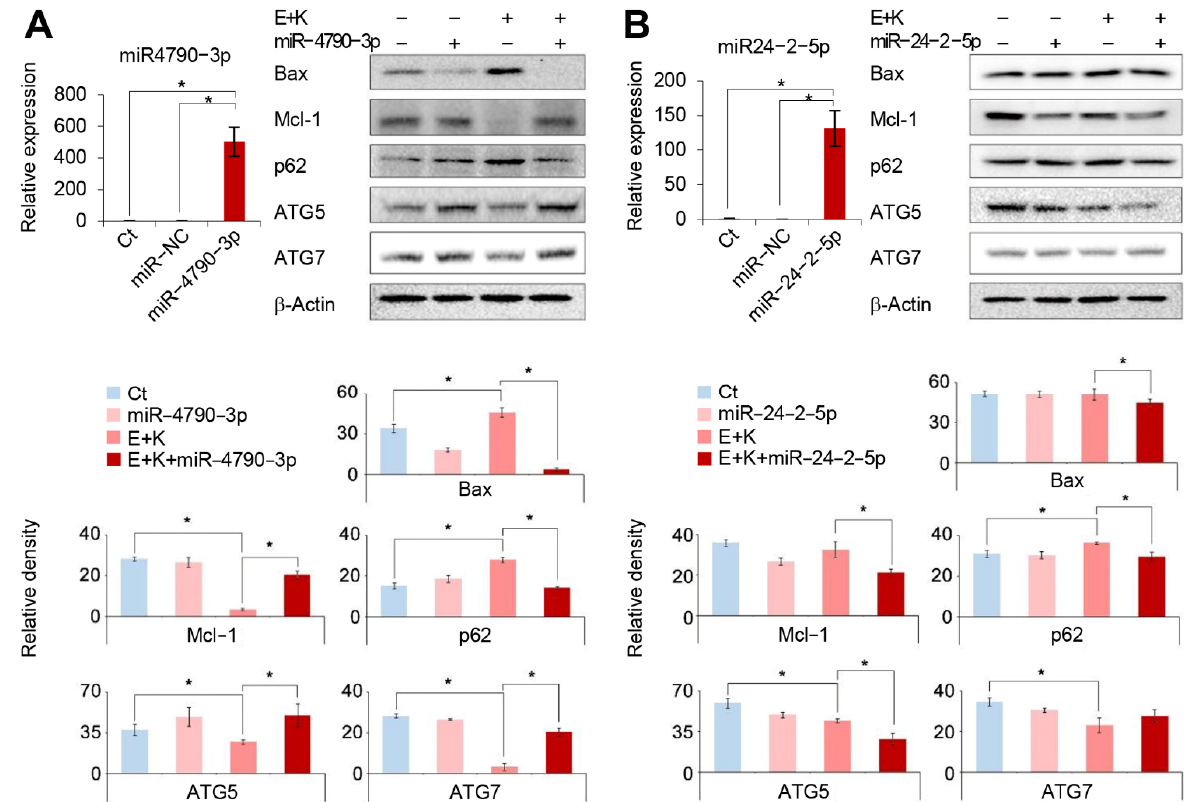
Figure 3. Overexpression test for the determination of the roles of miR-4790-3p and miR-24-2-5p. ( A ) (Left) Real-time PCR analysis demonstrating higher miR-4790-3p expression in miR-4790-3p-transfected HepG2 cells 24 h after transfection. (Right) Western blot analysis in HepG2 cells with miR-4790-3p overexpression following individual treatments. Overexpression of miR-4790-3p led to downregulation of Bax, upregulation of Mcl-2, and proapoptotic alterations (higher expression of ATG5 and ATG7 and lower expression of p62). ( B ) (Left) Real-time PCR analysis demonstrating higher miR-24-2-5p expression in miR-24-2-5p-transfected HepG2 cells 24 h after transfection. (Right) Western blot analysis in HepG2 cells with miR-24-2-5p overexpression following individual treatments. Overexpression of miR-24-2-5p did not lead to consistent alterations in the expression of proapoptotic, antiapoptotic, or autophagic proteins. Values are presented as means ± standard deviations of three independent experiments. Note: * p < 0.05. Abbreviations: Bax, Bcl-2-like protein 4; E, everolimus; K, Ku0063794; Mcl-1, myeloid cell leukemia 1; miR-NC, miRNA mimic negative control.